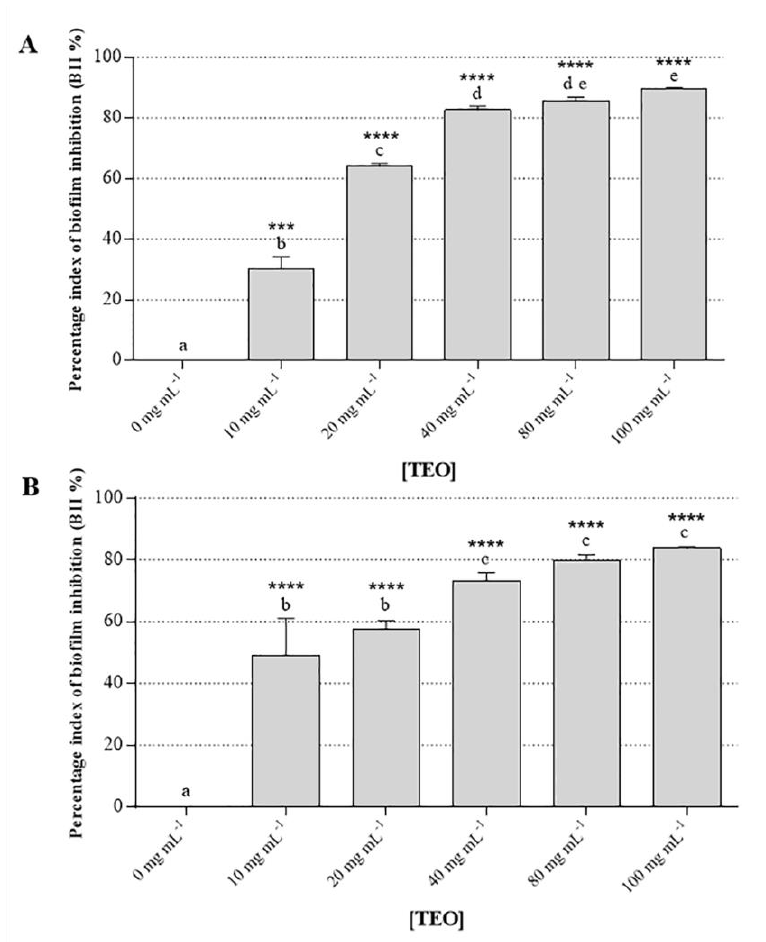
Figure 5. Inhibitory effect of thyme essential oil against biofilm formation by S. Typhimurium ST1 ( A ) and Bacillus cereus BC3 ( B ) food isolates. Graphs show the percentage inhibition values of biofilms in the presence and absence of increasing concentrations of TEO (10, 20, 40, 80, 100 µ L mL − 1 ). One-way ANOVA test was performed to evaluate statistical significance. Bars comparison with positive control bar (absence of TEO) was analyzed by Dunnett’s post hoc test ( p < 0.05), using asterisks to indicate statistical significance with respect to the positive control (**** p < 0.0001; *** p < 0.001). Tukey’s post hoc test ( p < 0.05) allowed to examine the statistical significance for multiple comparisons between bars. Different letters (a, b, c, d, e) indicate significant differences between bars; bars with no significant differences receive the same letter. TEO, thyme essential oil.